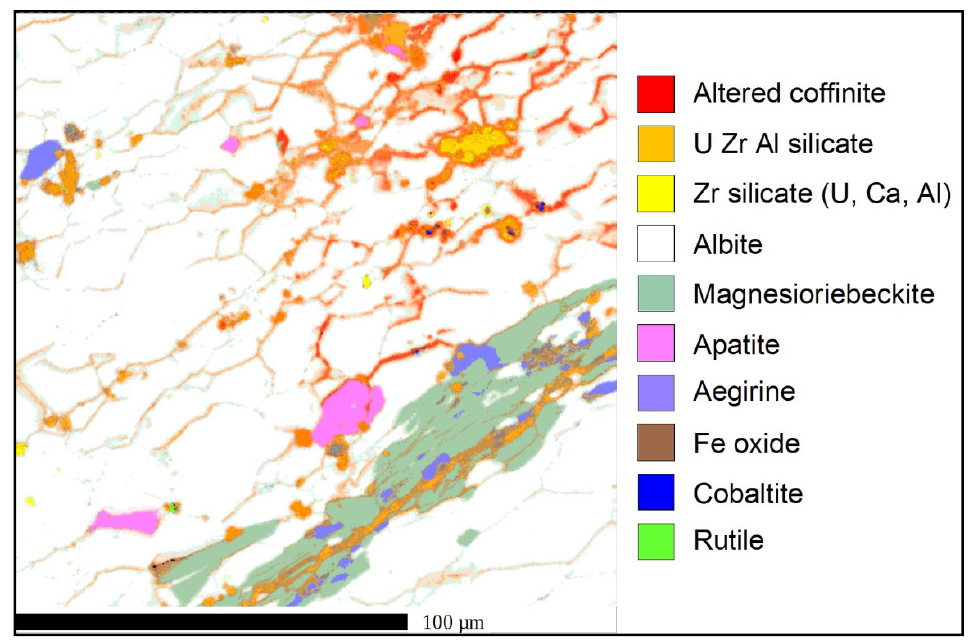
Figure 6 . FEG-SEM Images of ore from Valhalla showing typical occurrence of uranium